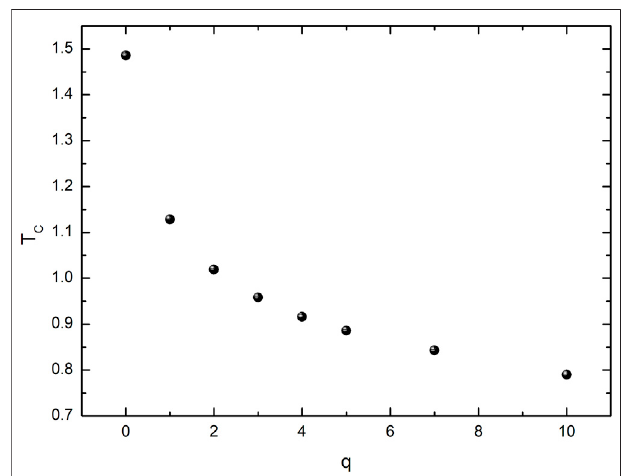
FIGURE5| Thevortexdensity ρ vs.1/Tfor q (cid:1) 5.Thesolidlineislinear fi t for 0 . 88 < T < 0 . 93.